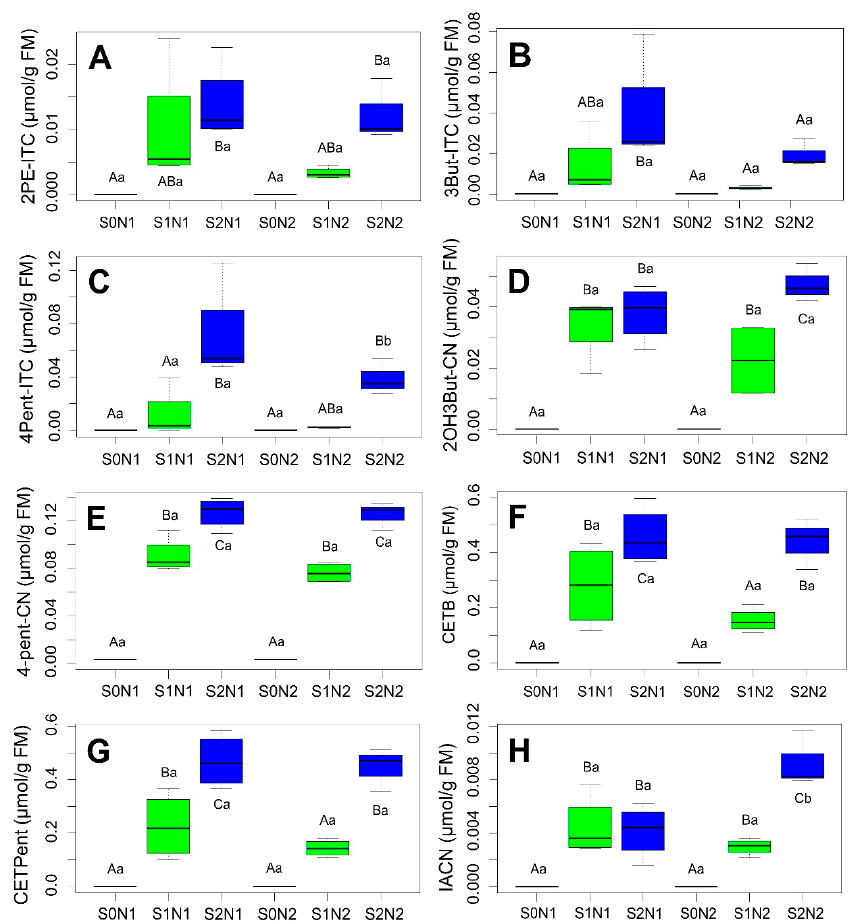
Fig. 6: Individual glucosinolate hydrolysis products under different N and S fertilization conditions in pak choi plants: 2-phenylethyl-isothiocyanate (2PE-ITC) (A), 3-butenyl-isothiocyanate (3But-ITC) (B), 4-pentenyl-isothiocyanate (4Pent-ITC) (C), 3-hydroxypentenenitrile (2OH3But-CN) (D), 5-hexenenitrile (4-pent-CN) (E), 1-cyano-3,4-epithiobutane (CETB ) (F), 5,6-epithiohexanenitrile (CETPent) (G), indolacetonitrile (IACN) (H). Lower- and uppercase letters indicate a significant difference (p<0.05) between means owing to the effect of N and S supply respectively, S0 = 0 g S, S1 = 0.06 g S, S2 = 0.3 g S, N1 = 0.75 g N, N2 = 1.5 g